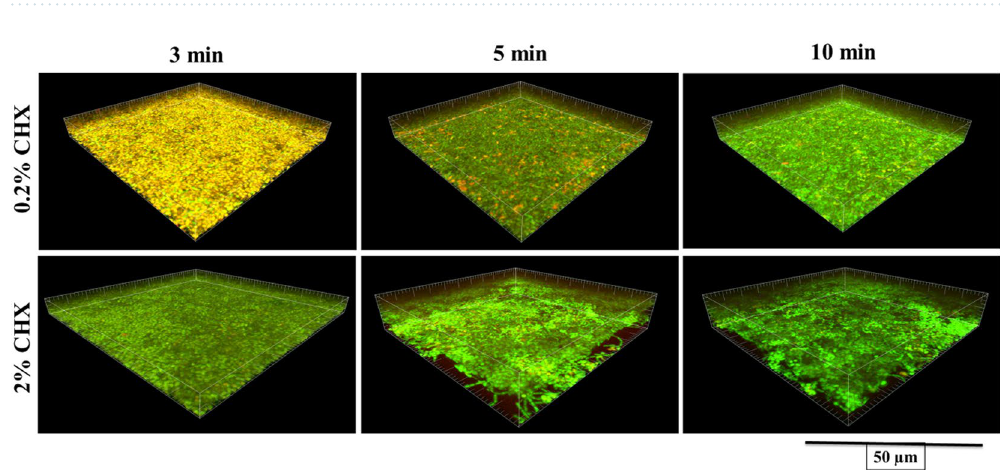
Figure 5. CLSM image of 48 h biofilms after treatment with different concentrations of CHX for 3 min, 5 min and 10